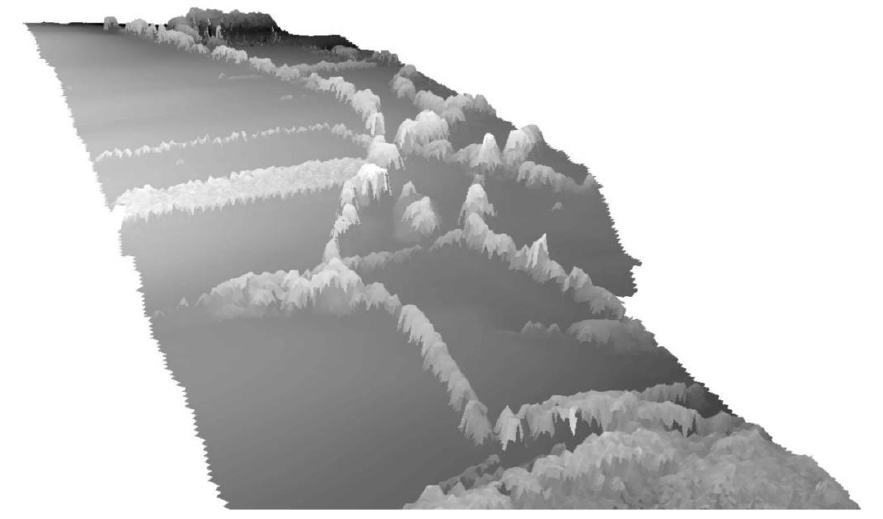
Figure 3. Visualization of the DSM.